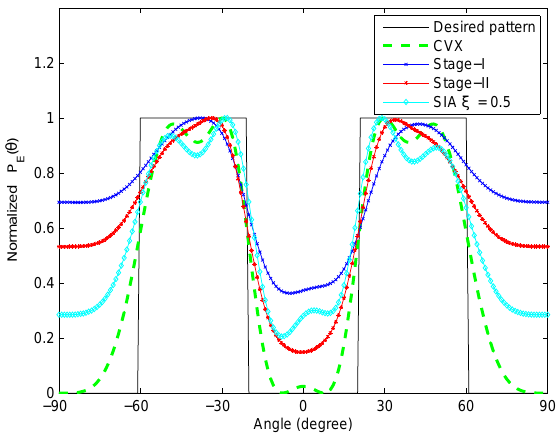
Figure 17. The optimized beampatterns for the two-main-lobe.